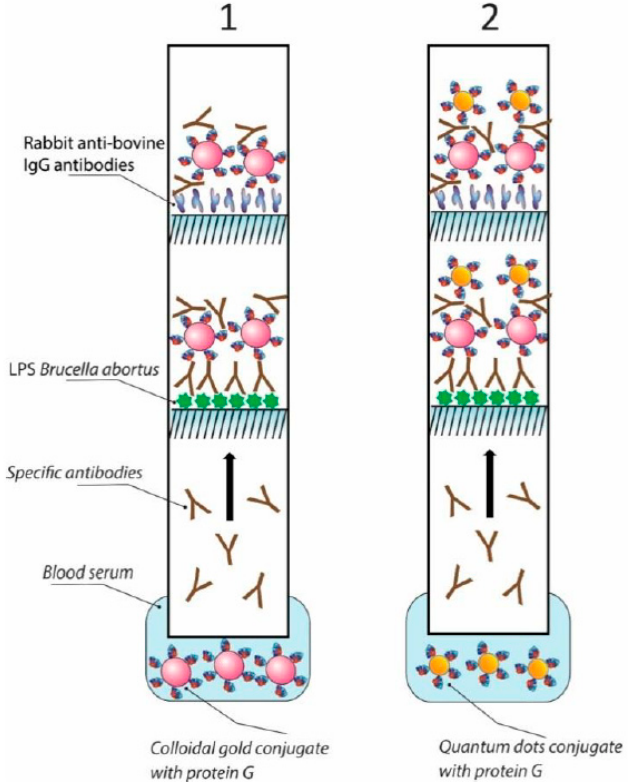
Figure 3. Scheme of immunochromatographic assay (ICA) with antibodies against LPS of B. abortus using GNPs and signal amplification with quantum dots (QDs). 1. Conducting ICA using the GNP-(protein G) conjugate. 2. Addition of the QD-(protein G) conjugate. Approbation of immunochromatographic test systems for detection of specific antibodies against LPS of B. abortus was performed on a panel of 83 positive sera with a confirmed diagnosis of brucellosis and 50 negative sera. Using the standard ICA technique with the GNP-(protein G) conjugate, 79 out of 83 sera were found to be strictly positive (signal > 0.5) (Table A1). Thus, the